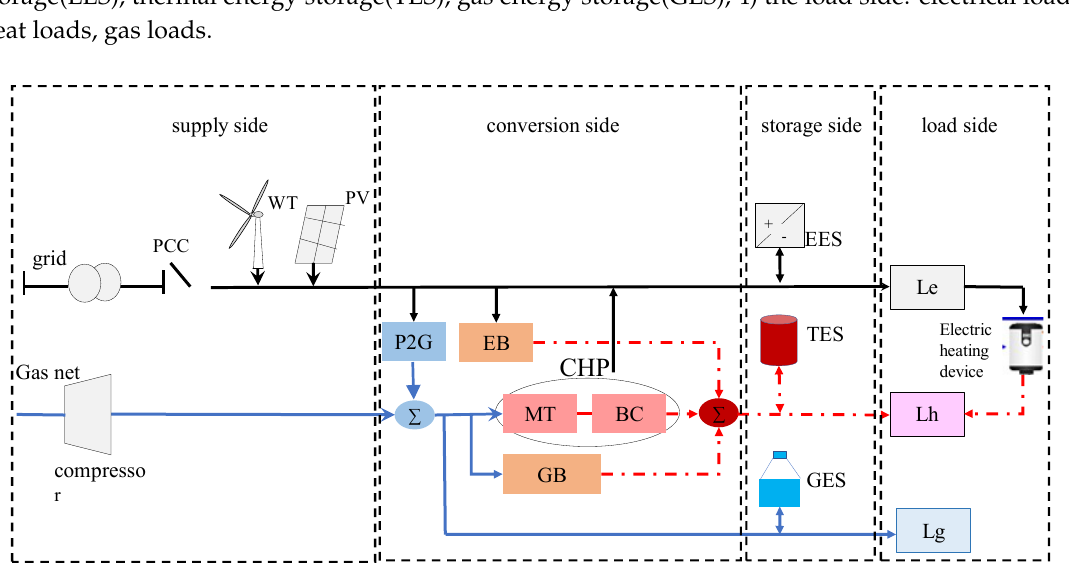
Figure 1. The typical regional integrated energy system (RIES) structure.